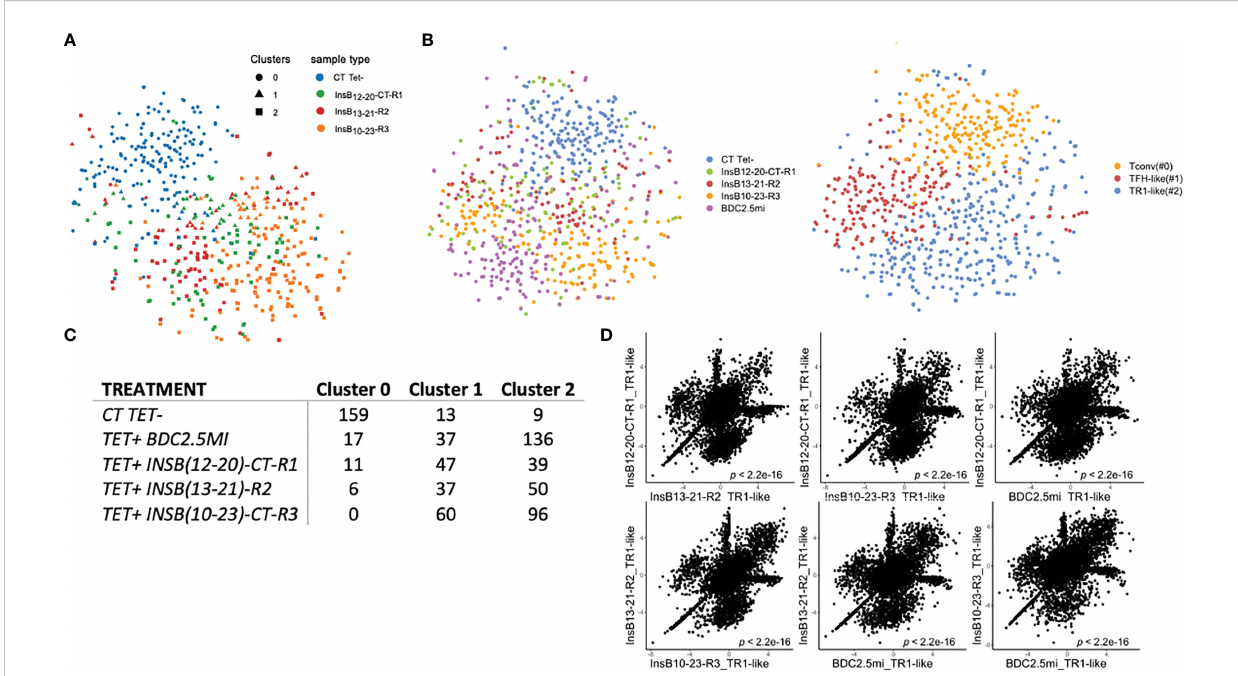
FIGURE 3 Single cell (sc) RNAseq analysis of tetramer+ CD4+ T-cells from pMHCII-NP-treated mice. (A) t-SNE plot of scRNAseq data for tetramer+ cells isolated from mice treated with InsB 12-20 -CT-R1/IA g7 -, InsB 13-21 -R2/IA g7 - or InsB 10-23 -CT-R3/IA g7 -NPs as compared to tetramer – cells (control) puri fi ed from InsB 12-20 -CT-R1/IA g7 -NP-treated mice. (B) t-SNE plots of scRNAseq data for cells from the mice in (A) plus tetramer+ cells from NOD mice treated with BDC2.5mi/IA g7 -NPs. Left, cluster types; Right, pMHCII speci fi cities. (C) Table depicting the number of cells belonging to each cell cluster as a function of tetramer-binding speci fi city. (D) Correlation between the levels of gene expression among TR1-like (cluster #2) cells from mice treated with InsB 12-20 -CT-R1/IA g7 -NP, InsB 13-21 -R2/IA g7 -NP, InsB 10-23 -CT-R3/IA g7 -NP and BDC2.5mi/IA g7 -NPs as compared to tetramer – cells (Tconv control) puri fi ed from InsB 12-20 -CT-R1/IA g7 -NP-treated mice. The P value refers to the Pearson correlation coef fi cient for each